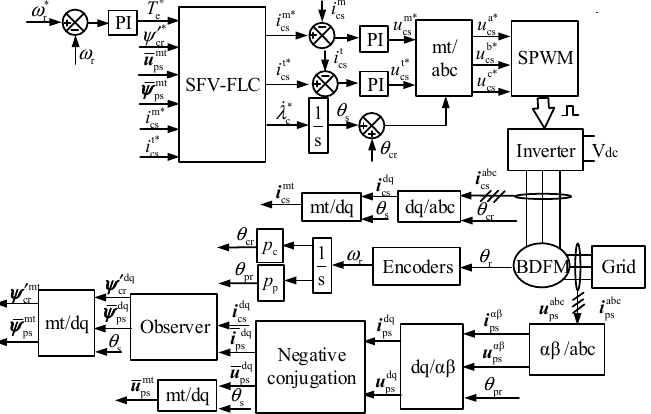
Figure 4. BDFM slip frequency vector feedback linearization control (SFV-FLC) block diagram.